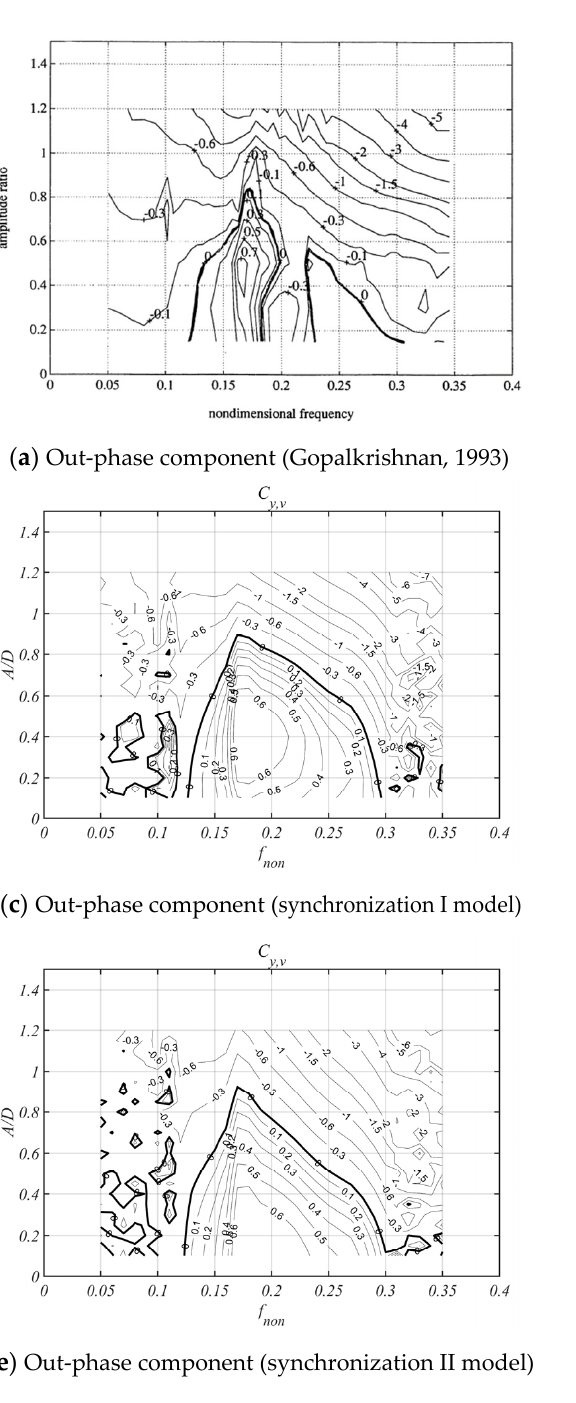
(5) Table 2. Simulation parameters, forced oscillations [32]. Item